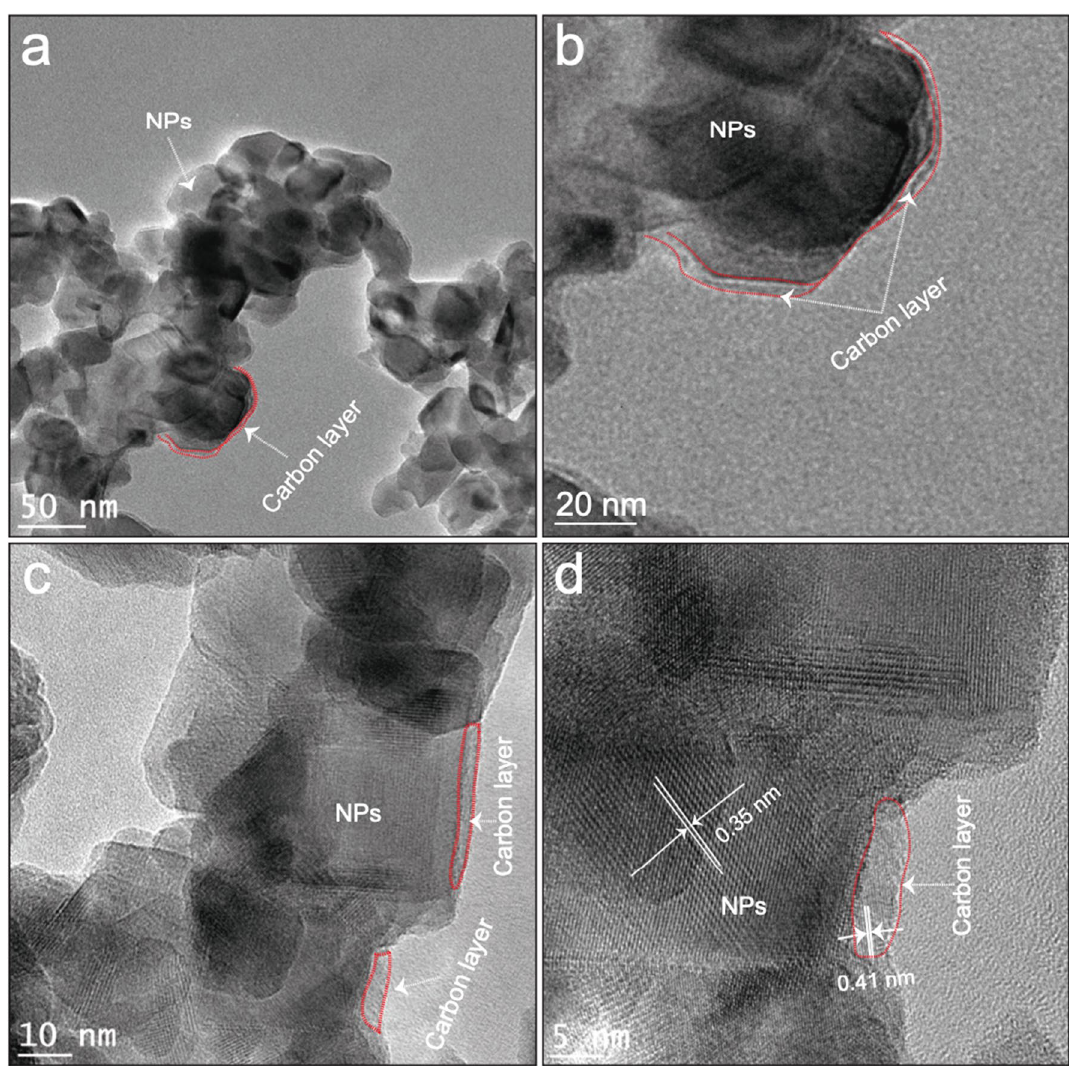
Figure 2. ( a ), ( b ), and ( c ) TEM images of TTOC-2 at different magnifications; ( d ) high-resolution TEM image of TTOC-2